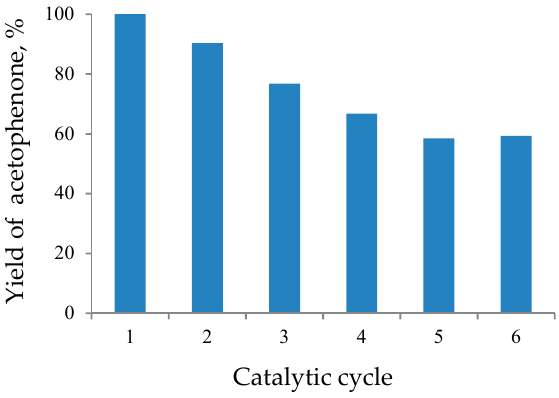
Figure 3. Effect of the catalyst recycling on the yield of acetophenone from peroxidative oxidation of 1-phenylethanol under catalyzed by 4% Au/La 2 O 3 /TiO 2 _H 2 (1.27 µmol Au, TBHP: 1-phenylethanol = 2.43,2 h, T = 80 °C).